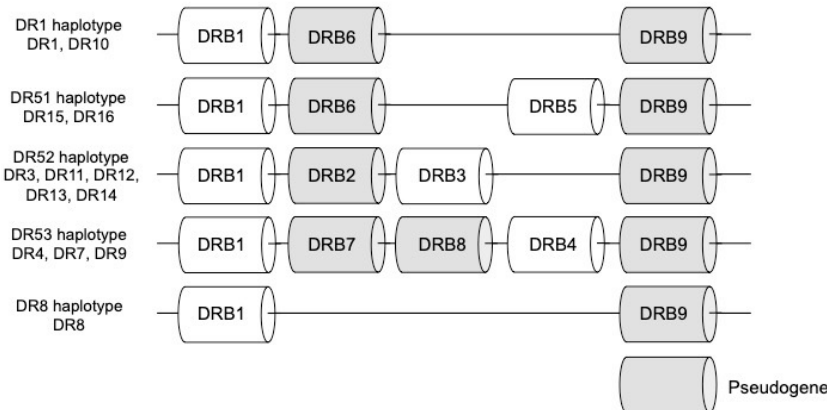
Figure 1. The human leukocyte antigen (HLA-DR) region is divided into five groups, DR51, DR52, DR53, DR1, and DR8, depending on the number and combination of genes. Gray box indicates pseudogene.